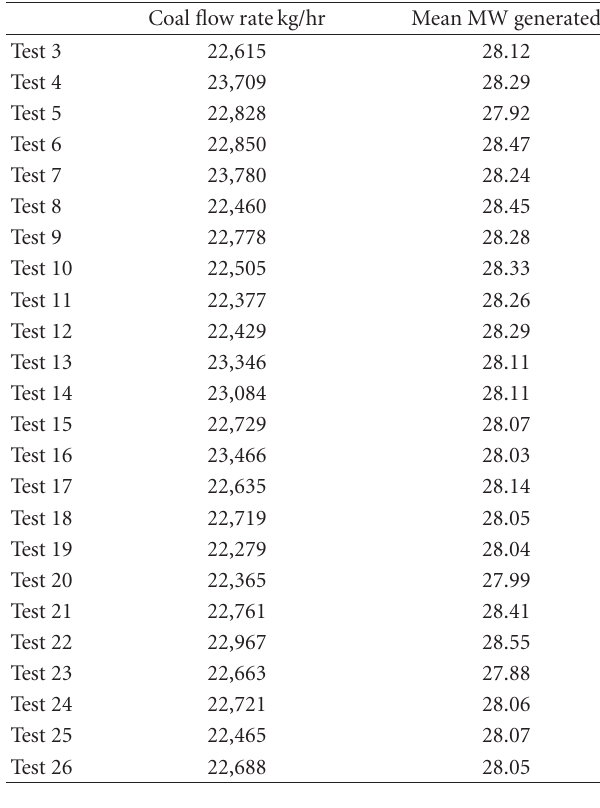
Table 5: E ffi ciencies for the various tests.